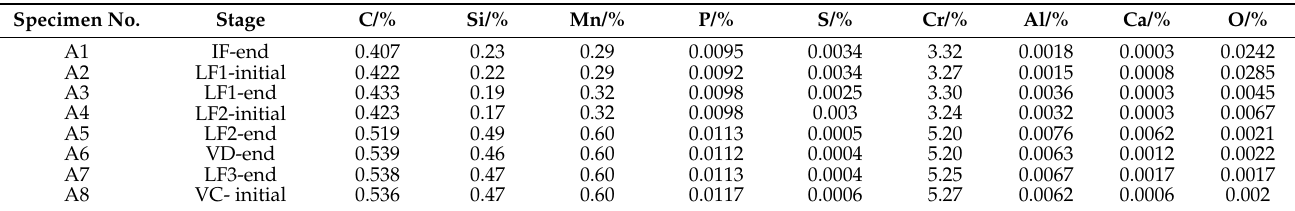
Table 1. Main chemical composition of steel specimens in mass